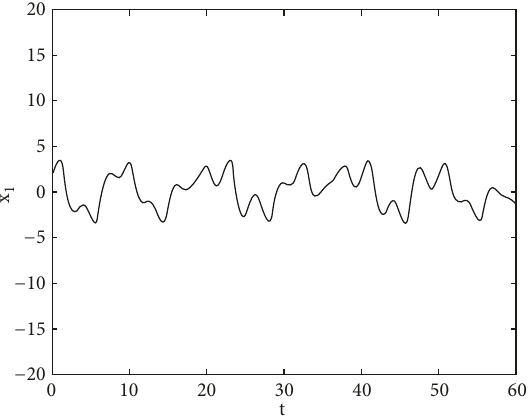
Figure 1: Chaotic attractor of Arneodo system.